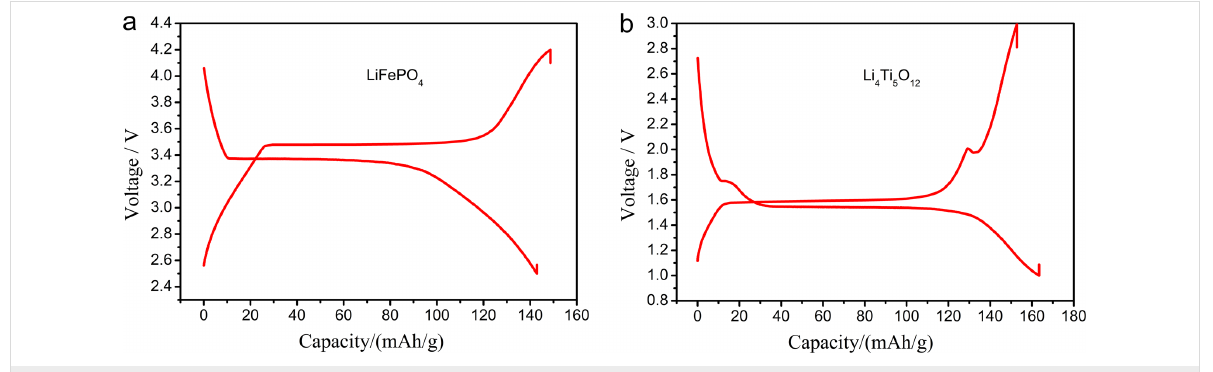
Figure 8: Charge–discharge curves of LiFePO 4 and Li 4 Ti 5 O 12 fiber membrane electrodes.